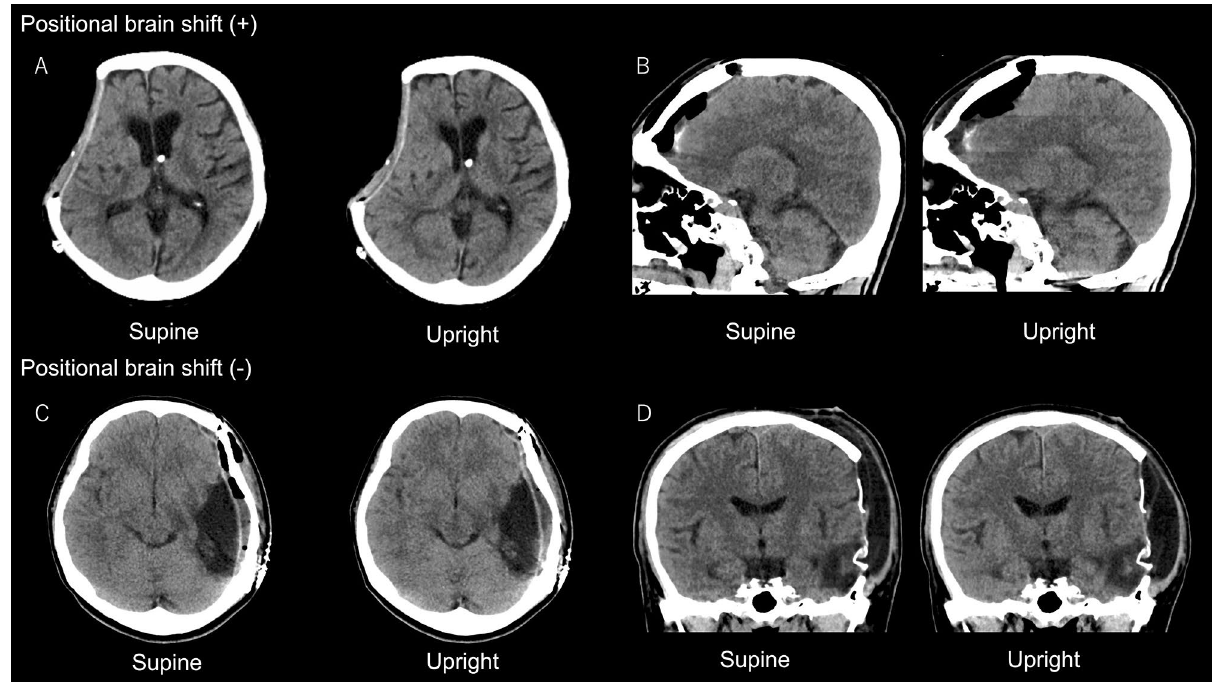
Figure 2. Examples of cases with ( A , B ) and without ( C , D ) positional brain shift (PBS). ( A ) A 70-year- old woman with ventriculoperitoneal shunt, who underwent craniectomy because of surgical site infection. Computed tomography (CT) scan images obtained on postoperative day (POD) 7 showed a remarkable PBS. ( B ) A 53-year-old man who underwent frontal craniotomy for clipping of a distal anterior cerebral artery aneurysm. In total, 14.9 mL of residual air, which moved upward according to positional change, thereby compressing the frontal lobe, was evident on CT scan images on POD 7. ( C ) A 41-year-old woman who underwent resection of left temporal glioma. CT scan images on POD 7 did not show PBS around the resection cavity. ( D ) A 55-year- old man who underwent craniectomy for traumatic brain injury. CT scan images on POD 17 did not show PBS. However, subcutaneous fluid collection indicated a positional shift. Multivariate analysis Variable With PBS (n = 21) Without PBS (n = 46) p value univariate analysis OR (95% CI) p